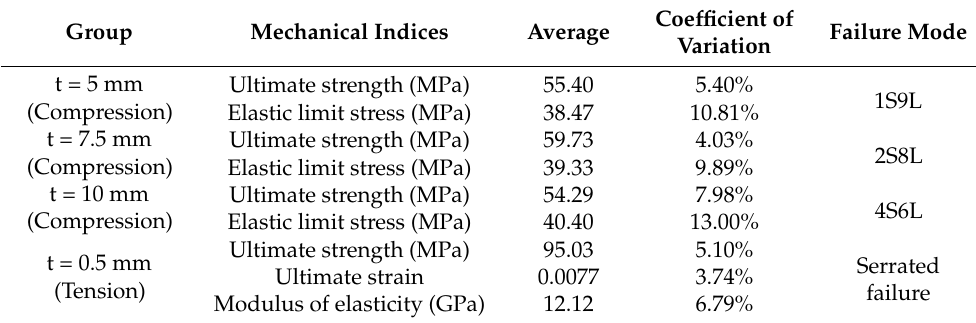
Table 1. Mechanical properties of bamboo